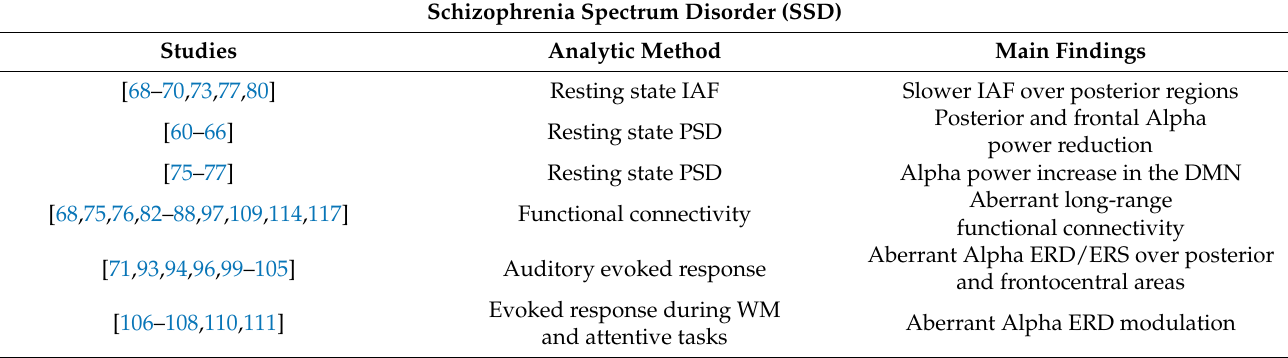
Table 2. Table representing the main electrophysiological findings in SSD, with the methods and the studies who contributed to